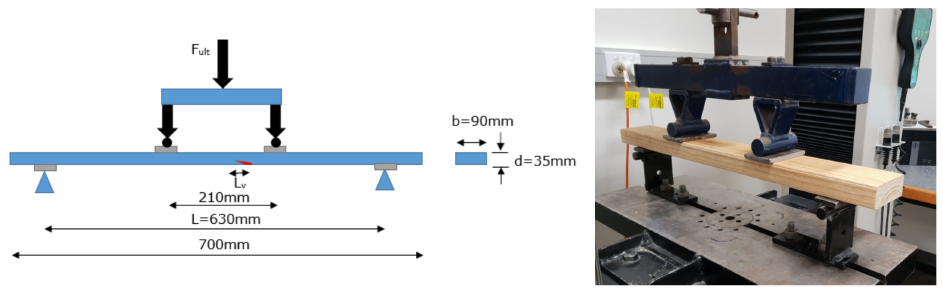
Figure 3. Four-point bending test configuration.